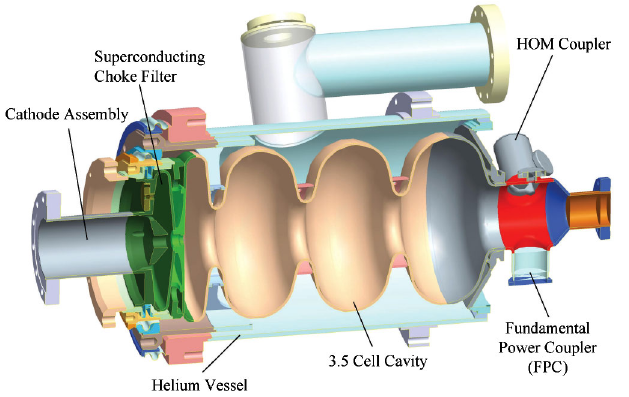
FIG. 2. 1.3 GHz—3.5 cells TESLA shaped FZD SRF gun cavity.